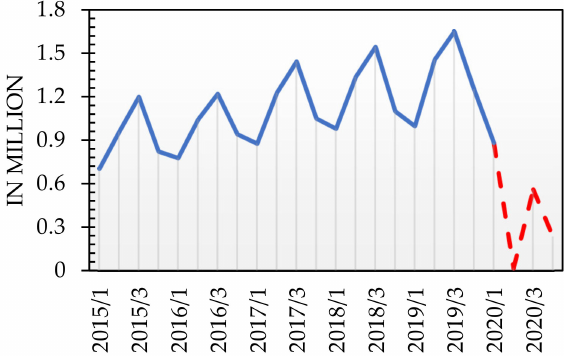
Figure 3. Number of passengers at Gda´nsk R˛ebiechowo